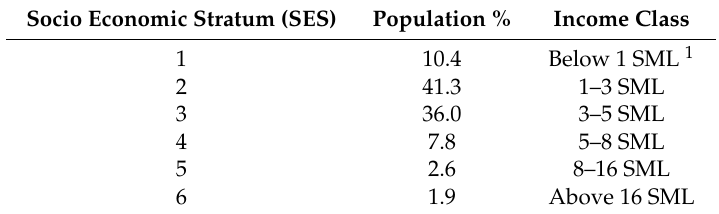
Table 1. Population and income class per socio-economic stratum (based on